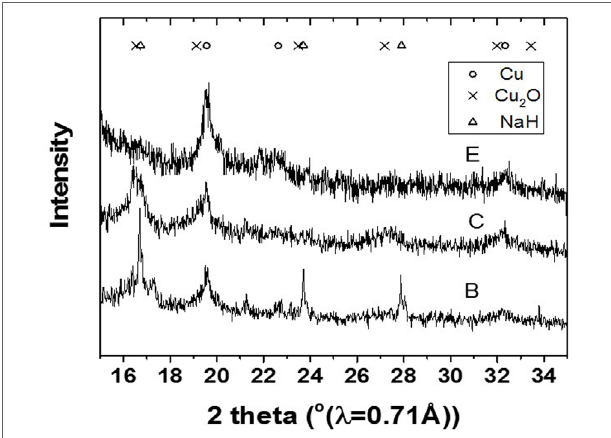
FigUre 2 | X-ray diffractogram of the slurry after the steps B, C, and D in Figure